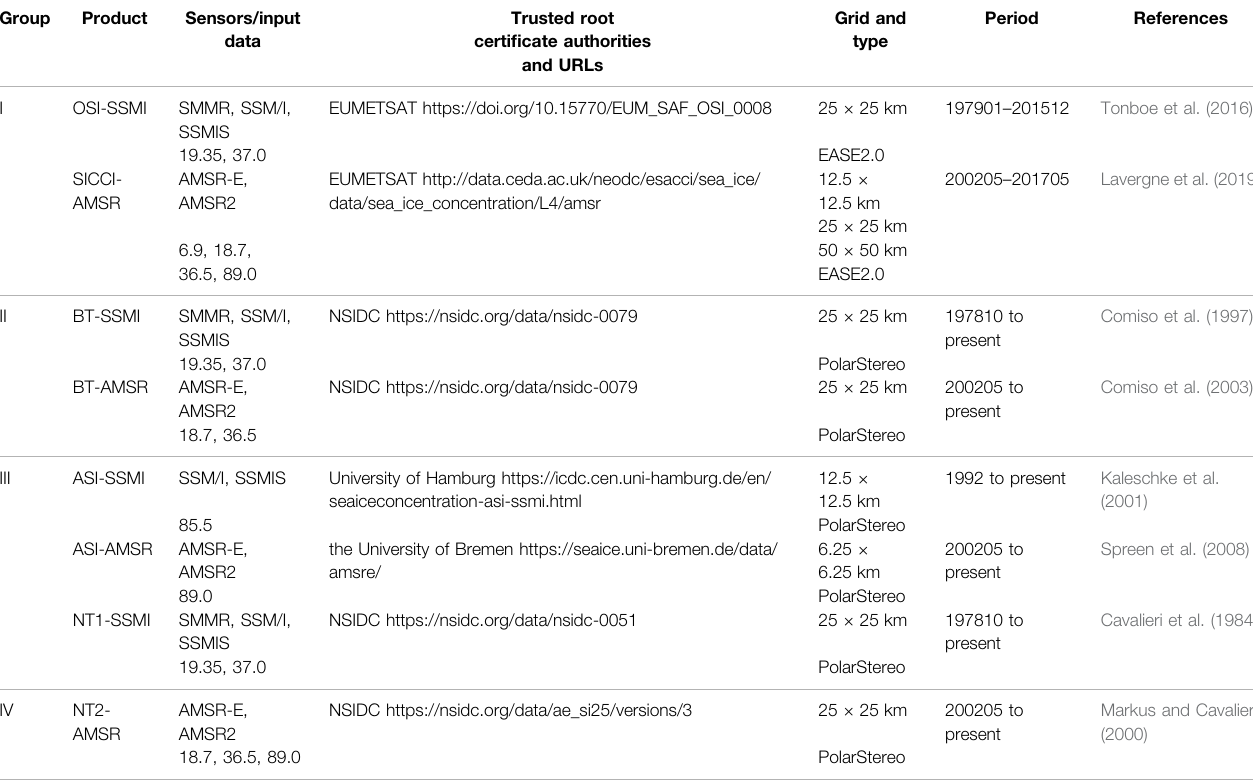
TABLE 2 | Overview of passive microwave sea ice concentration retrieval algorithms and products used in this paper (Kern et al., 2019; Kern et al., 2020).